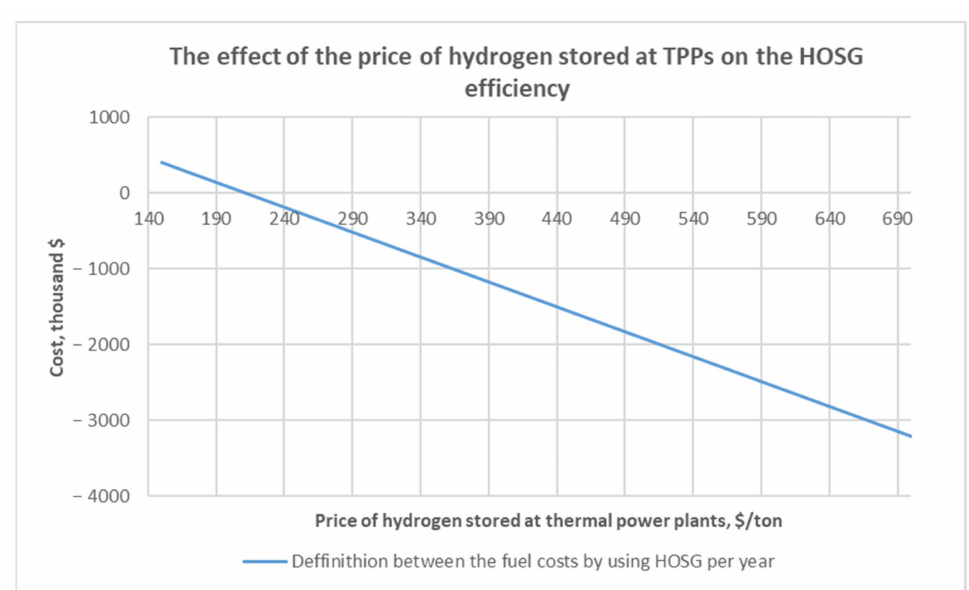
Figure 11. The effect of the price of hydrogen stored at TPPs on the HOSG efficiency in the case of replacement of a part of the steam generated by the boiler unit with the help of the HOSG.